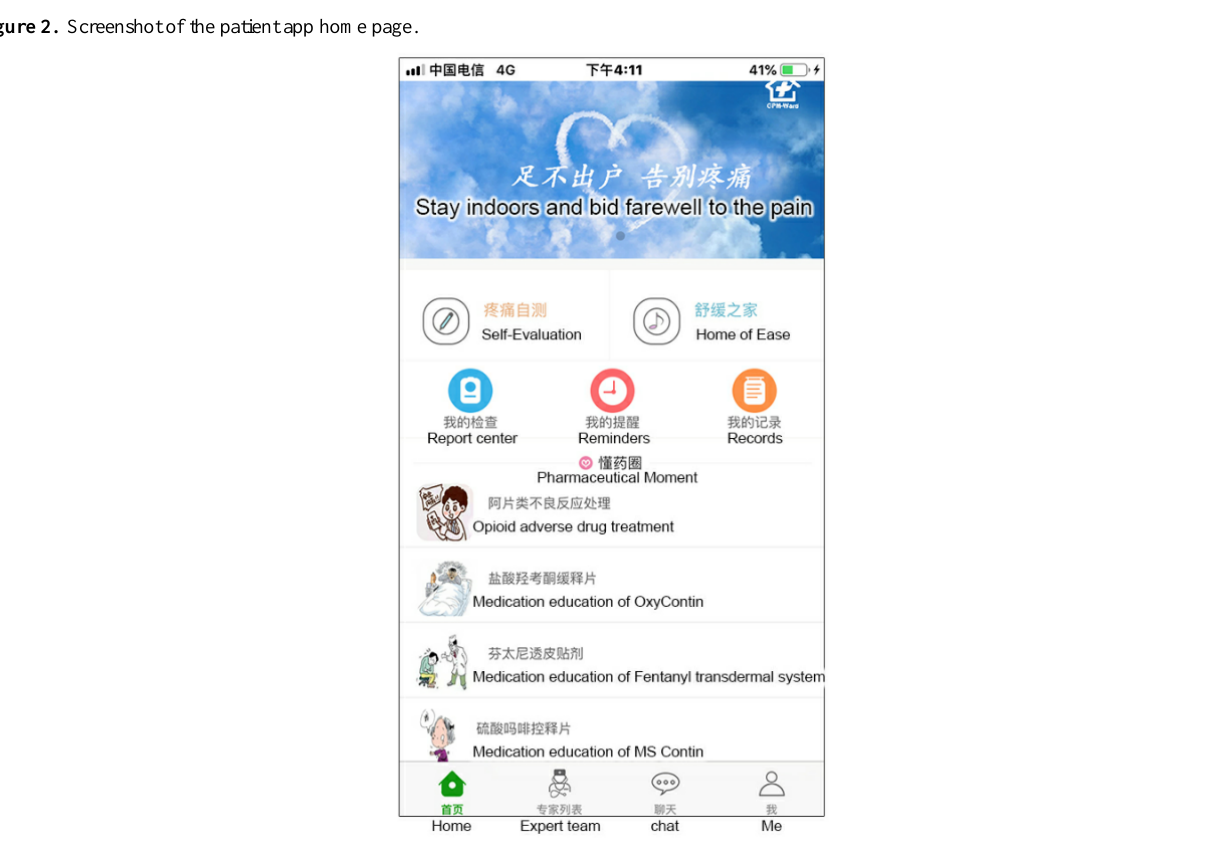
Figure 2. Screenshot of the patient app home